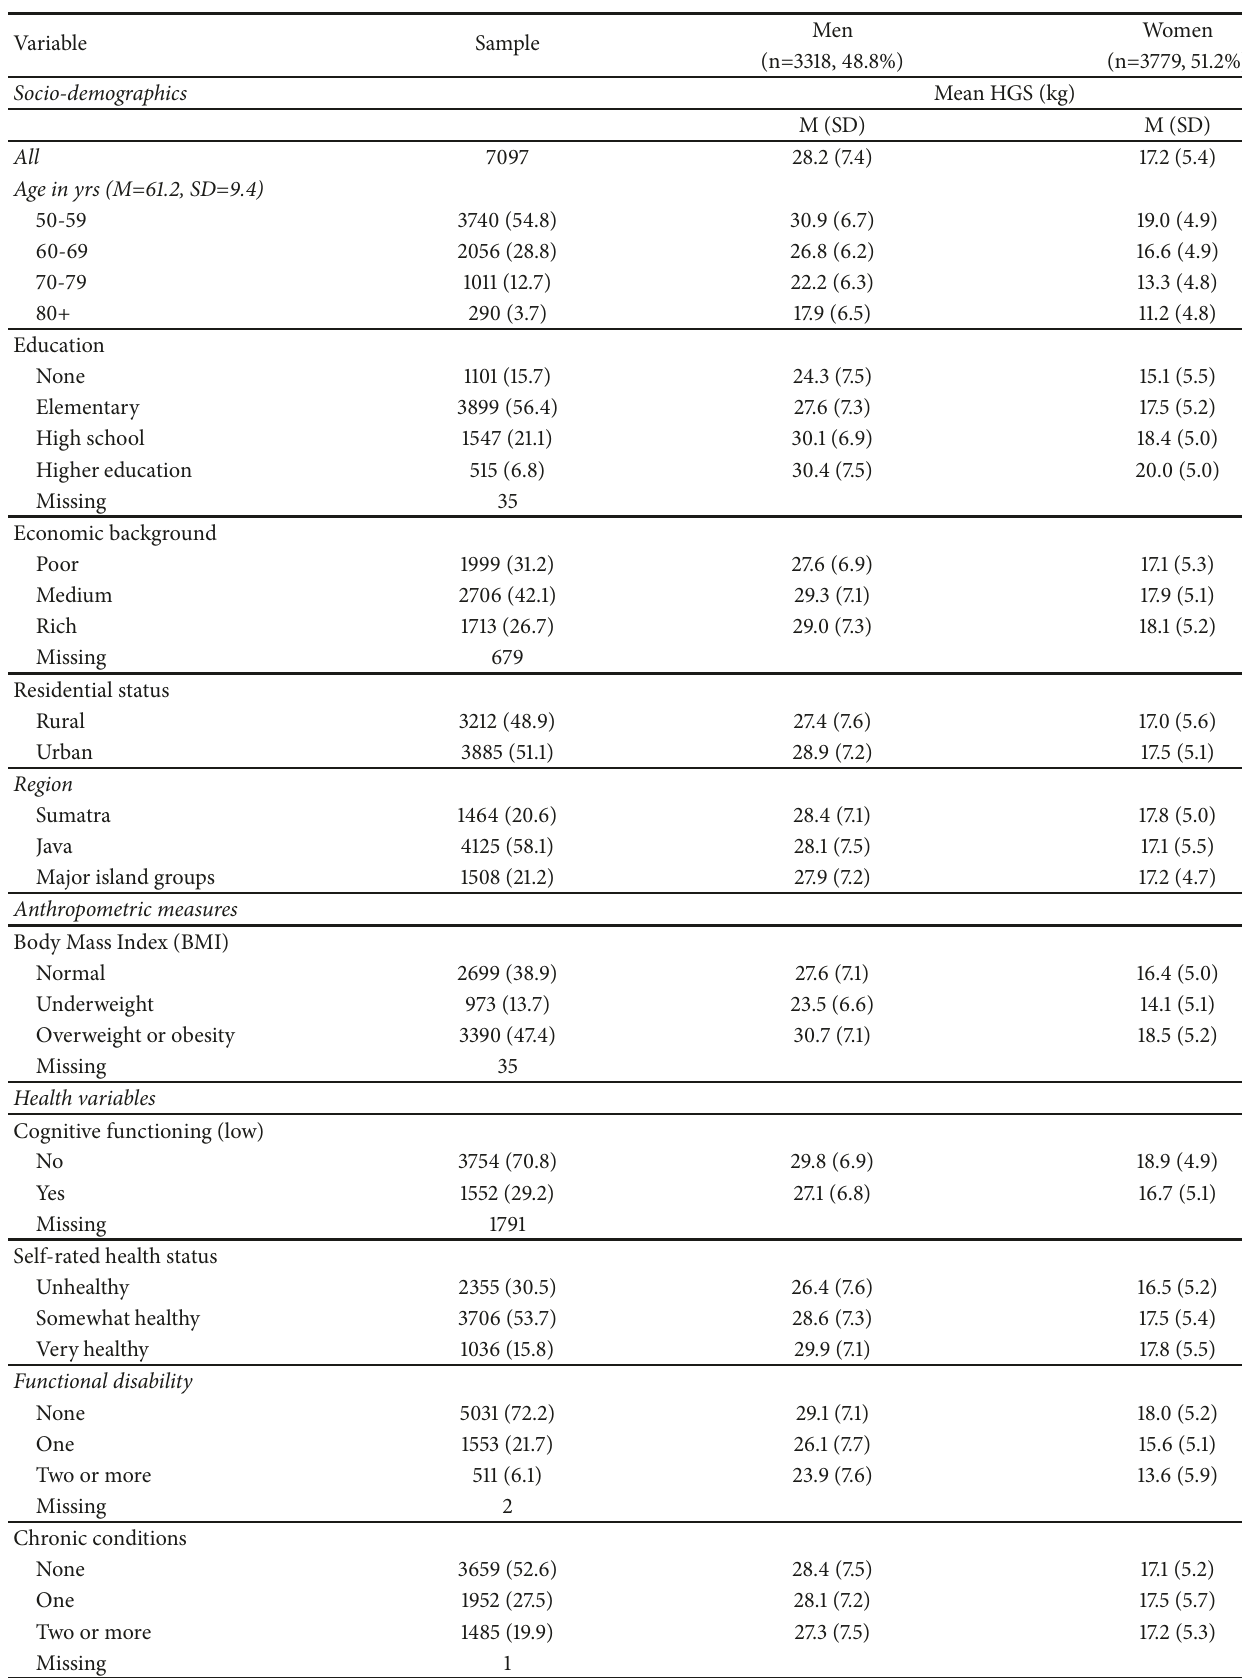
Table 1: Sample characteristics and mean hand grip strength (HGS) among older adult men and women in